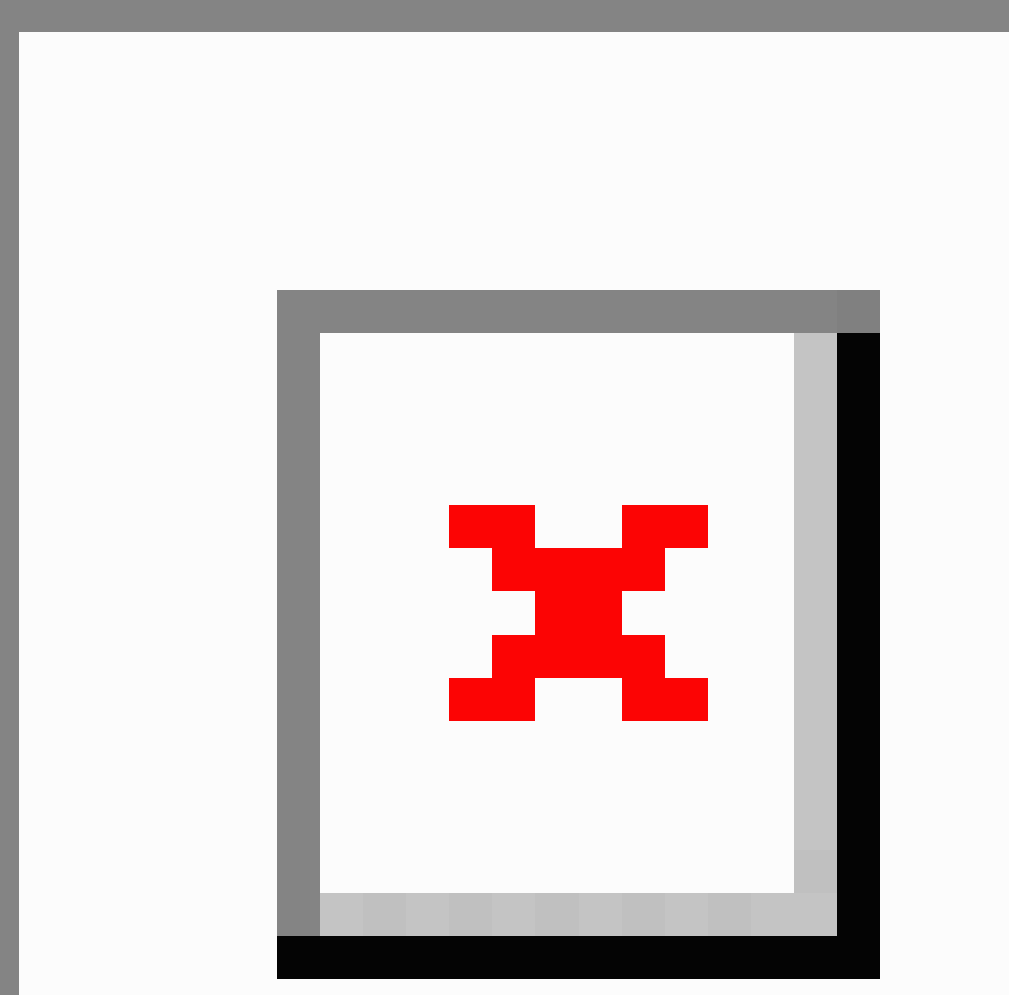
Figure 6. Attitudes and interests of students about using the interactive algorithms as part of their medical or health care